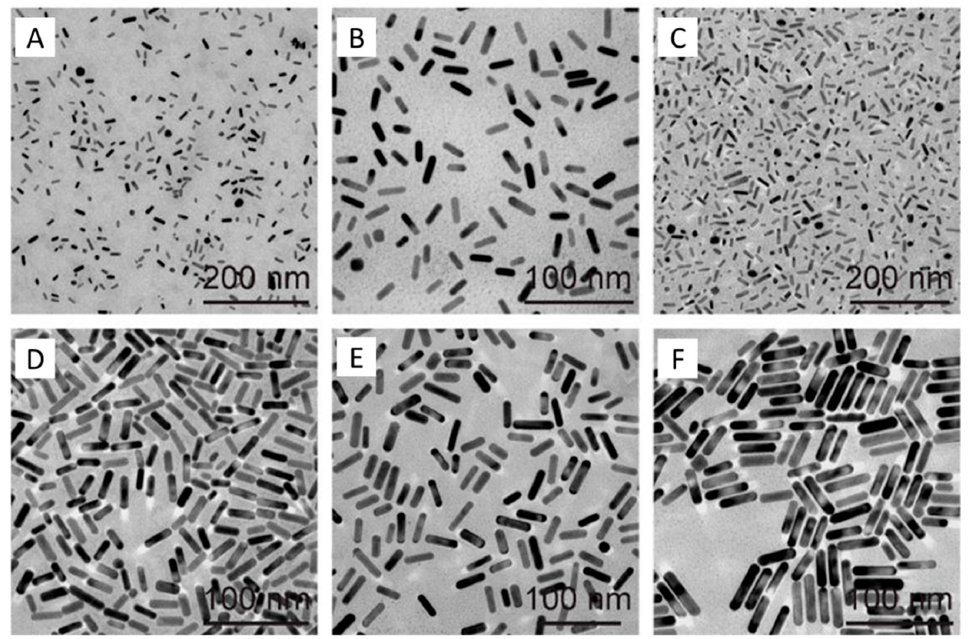
Figure 1. Transmission electron microscopy (TEM) images of the small Au nanorods samples (GmSn) obtained with different molar ratio of seed-to-Au(III) in the growth solution. ( A – C ) G1S9, G2S8, and G4S6 were grown with cetyltripropylammonium bromide (CTPAB), and ( D – F ) G6S4, G8S2, and G9S1 were grown with CTAB [38].